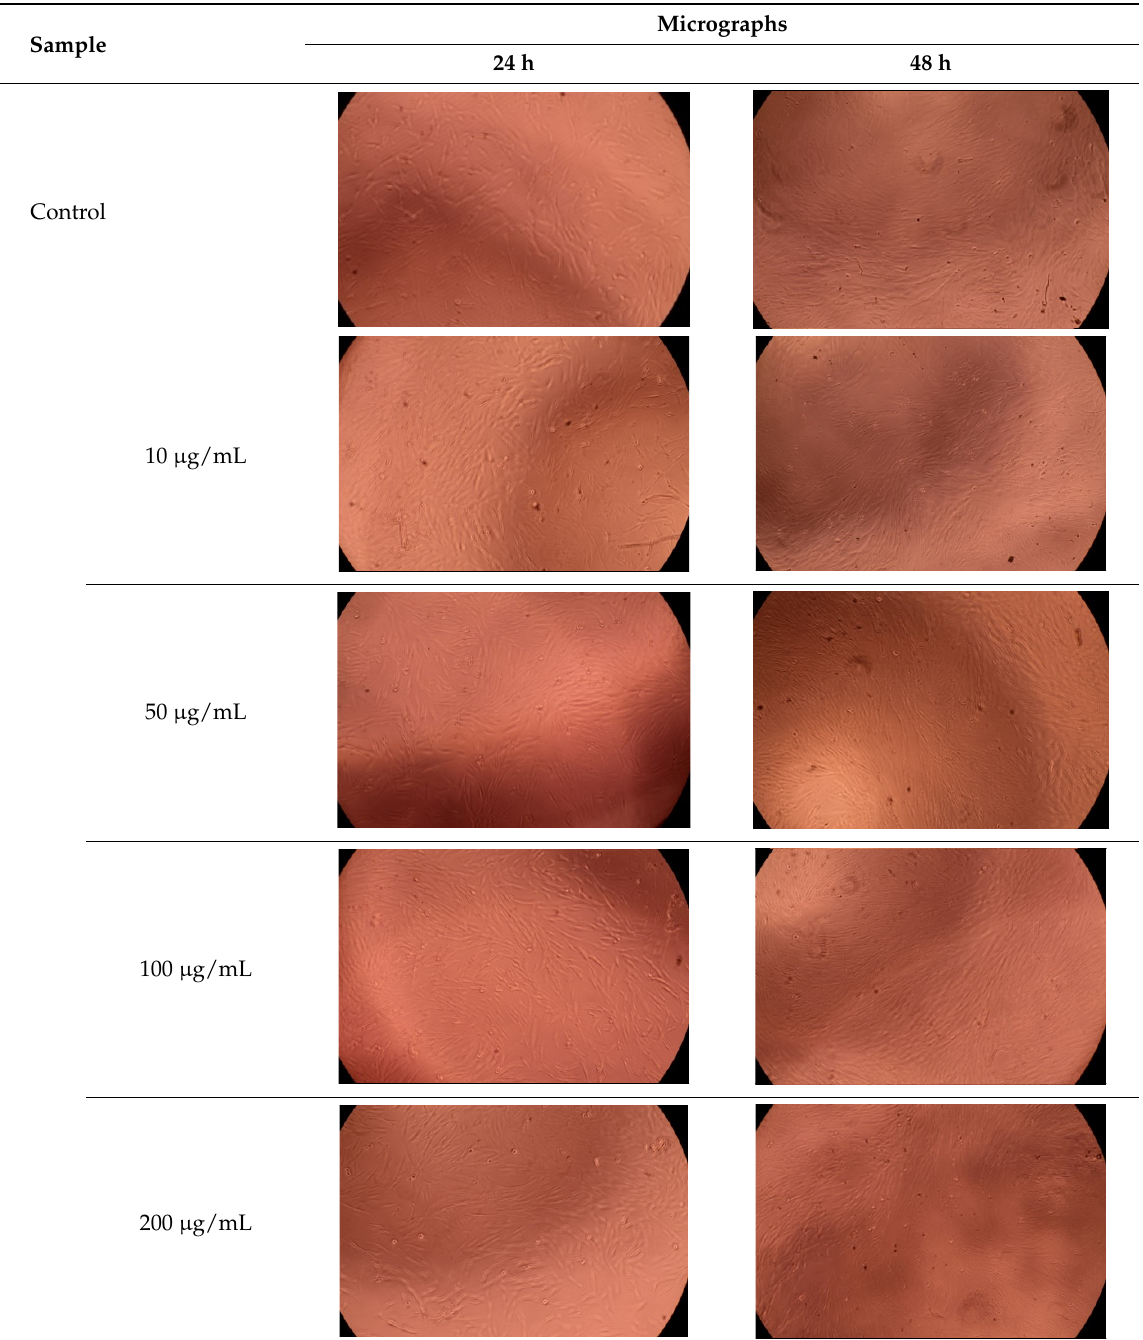
Table 3. Micrographs of the fibroblast cells after 24 and 48 h.